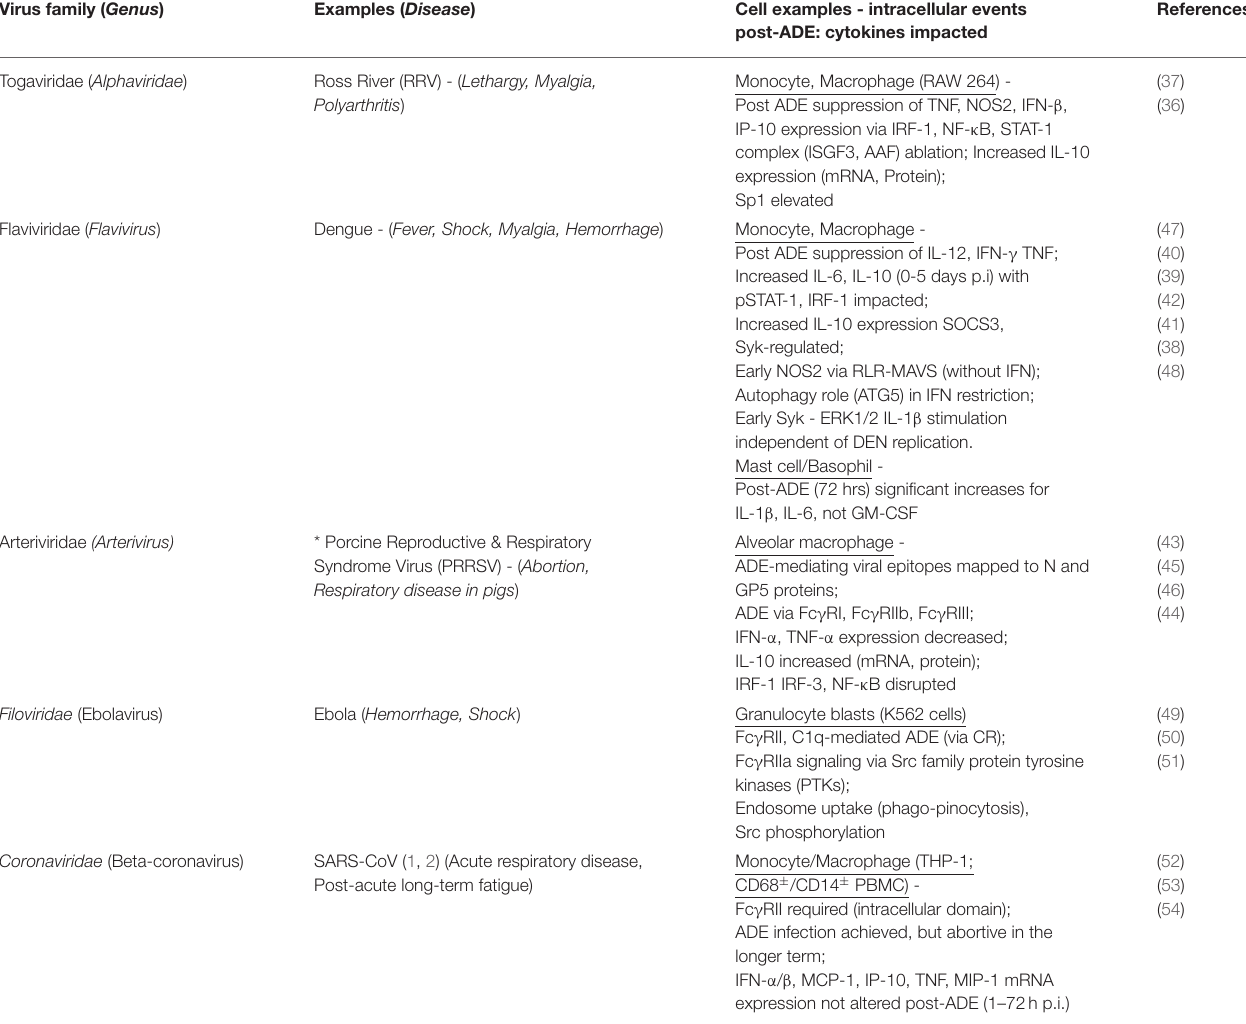
TABLE 1 | Examples of ADE-mediated virus infections and the impact on subsequent cellular pathways and cytokine expression. Virus family ( Genus